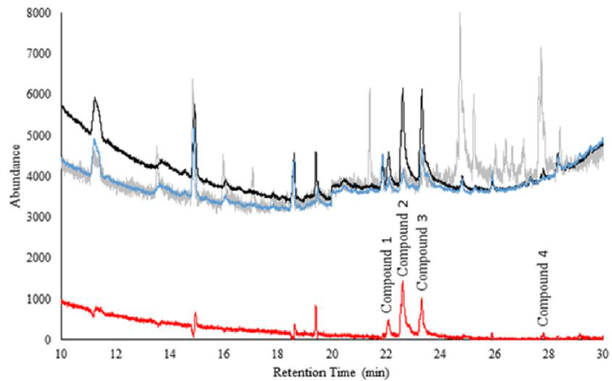
Figure 1. Comparison of averaged ‘sick’ and ‘healthy’ cattle nasal swab samples. The gray is the possible background contributed by the tissues used. The black is the average of all 50 ‘healthy’ cattle samples. The blue is the average of all 50 ‘sick’ cattle samples. The red is the standard deviation between the ‘sick’ and the ‘healthy’ cattle samples (to visualize the presence of probable markers). Compounds 1 – 4 are significantly different (peak areas) between the ‘sick’ and ‘healthy’ cattle samples ( p = 0.001, p < 0.0001, p < 0.0001 and p = 0.0358, respectively). It is remarkable to note that